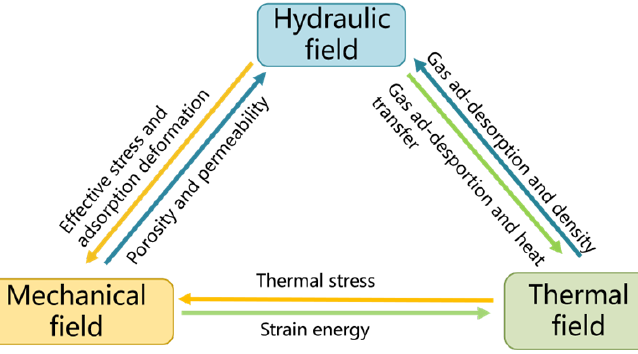
Figure 3. T - H - M coupling relationship.